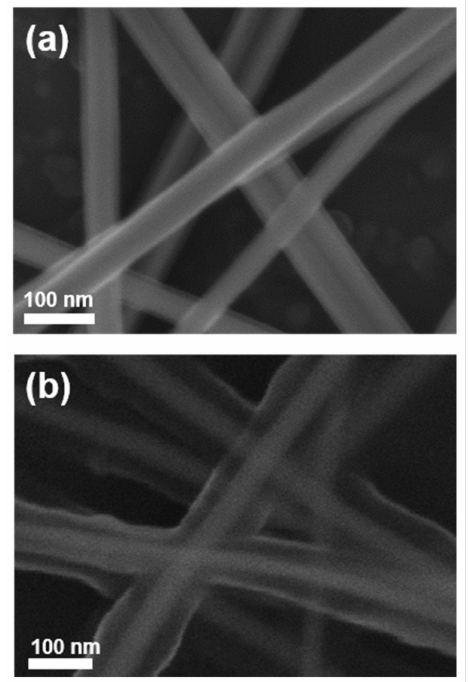
Figure 2. FE-SEM images of the ( a ) bare AgNWs and ( b ) APTES-AgNWs. The principle of adhesion enhancement is explained in Figure 3. The APTES molecules comprise amine (–NH 2 ) functional groups and silanol groups (Si–OH), which have a high affinity to Ag and form covalent bonds with Ag atoms. The APTES molecules are randomly entangled with each other on the AgNWs via condensation and the formation of hydrogen bonds, forming a thick capping layer, as shown in Figure 2b. Owing to the random orientation of the APTES molecules in the capping layer, amine and silanol groups are abundant on the surface of the capping layer. Moreover, these functional groups can be strongly bound to the hydroxyl-rich glass slide and plasma-treated PE substrate, owing to the formation of hydrogen and siloxane bonds [34]. After annealing, the loosely bounded APTES molecuels are eliminated. Nevertheless, in this work, APTES-AgNWs networked film shows strong adhesion to the substrate after annealing because chemically bound APTES on the AgNWs surface are stable at 180 ◦ C and it still contributes adhesion of APTES-AgNWs films [35]. To confirm the presence of the APTES capping layer, the N1s X-ray photoelectron spectroscopy (XPS) spectrum of the APTES-AgNWs was studied, as presented in Figure 3b. N1s spectrum of APTES-AgNWs was deconvoluted into two peaks at 402.2 eV and 399.2 eV, corresponding to the amine groups from the APTES molecules and C-N bond from the PVP layer, respectively